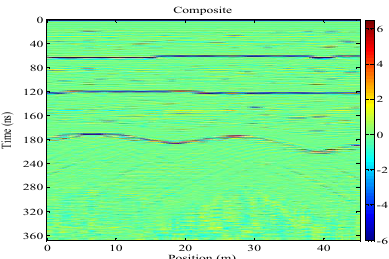
Figure 5. Test data and IMF components obtained by decomposing the simulated data with VMD.